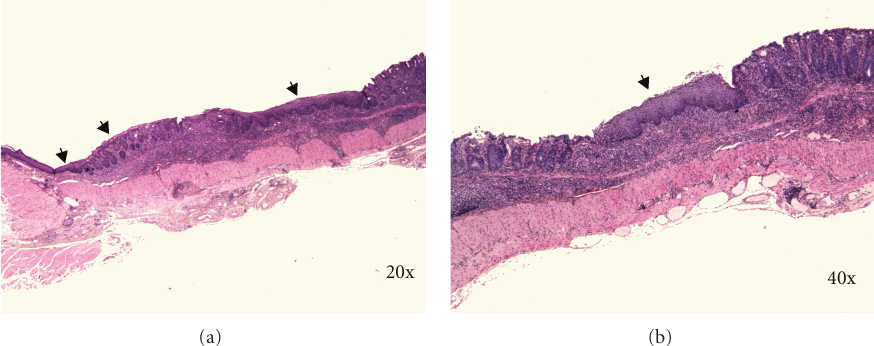
Figure 7: (a) and (b) reepithelisation of rectal and distal colonic erosion by squamous epithelium (arrows). C57BL/6JOlaHsd male mice are exposed to 3% DSS solution for 5 days followed by drinking water for 7 days. Kreyberg trichrom stain (acid mucopolysaccharides are stained